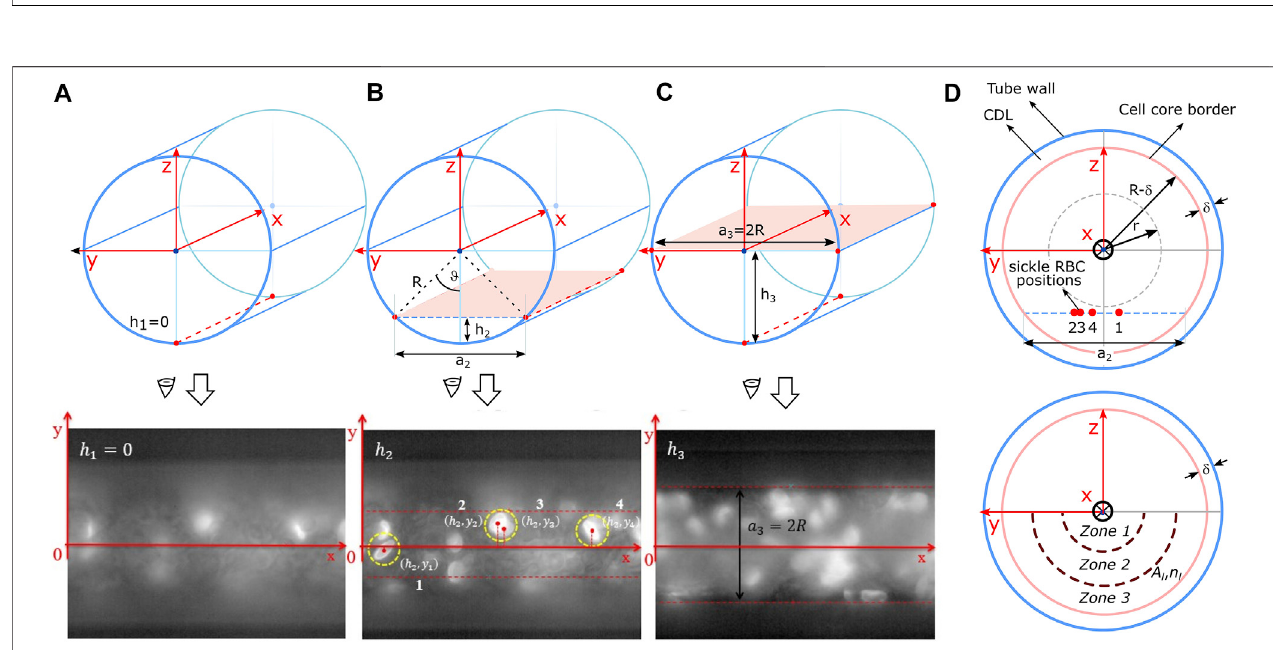
FIGURE 2 | Experimental setup. A high-precision pressure device with two independent pressure lines 1 and 2 was used to fl ow and stop the fl ow of the sample inside the glass capillaries. Glass capillaries were surrounding by PDMS to decrease light diffraction. ER1 and ER2 are the external sample reservoirs integrated to the fl ow lines and sealed to the exterior to avoid leaking and pressure loses. Observations were made 1 cm onwards the channel entrance as shown in the scheme. At the right, examples of fl uorescence (top) and bright fi eld (bottom) images are shown.